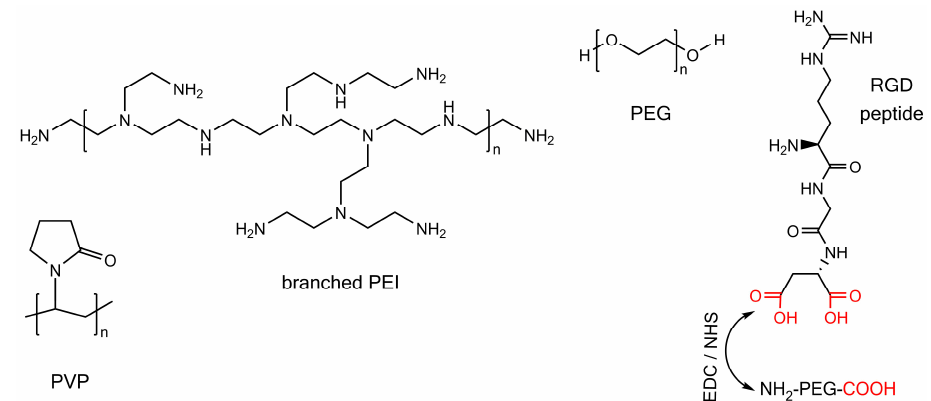
Figure 7. Polymers for Ni nanorod surface modification. From left to right, these polymers are: polyvinylpyrrolidone (PVP), branched polyethyleneimine (PEI), polyethylene glycol (PEG), and a RGD peptide bound to a polyethylene glycol modified with a carboxyl and an amine group. Carboxyl groups are shown in red. The amine group of the PEG is bound to the RGD peptide via EDC/NHS linker chemistry.